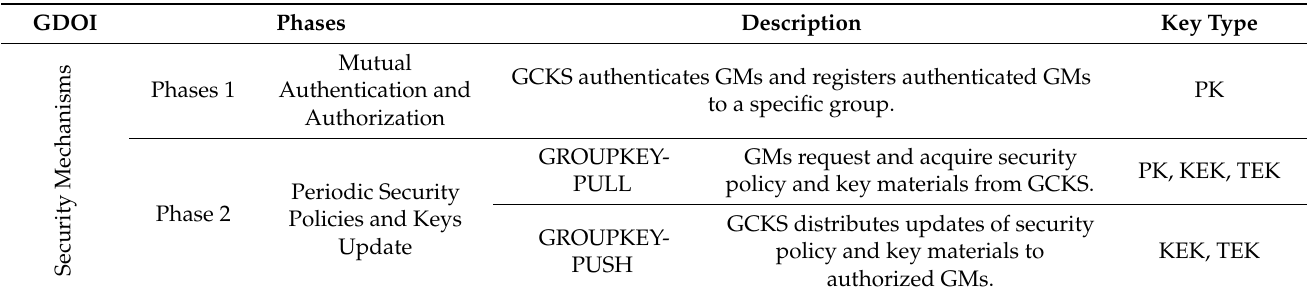
Table 4. Description of GDOI mechanism and keying materials between GCKS and GM.